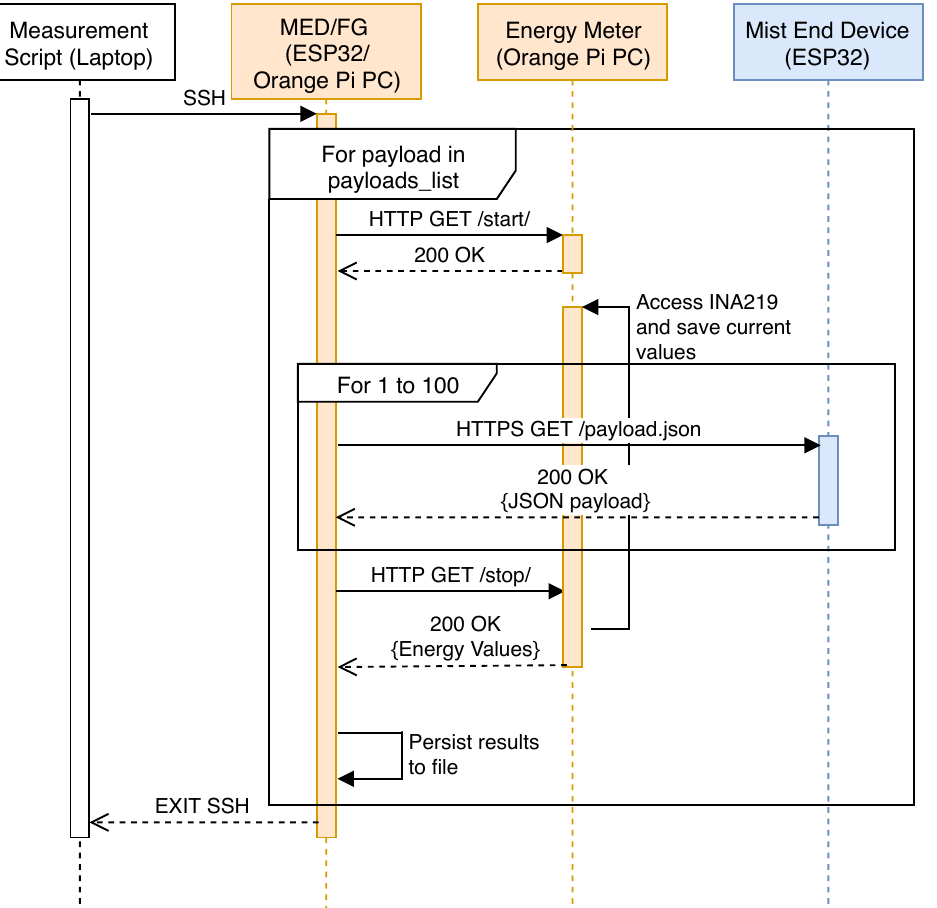
Figure 5. Sequence diagram of the testing